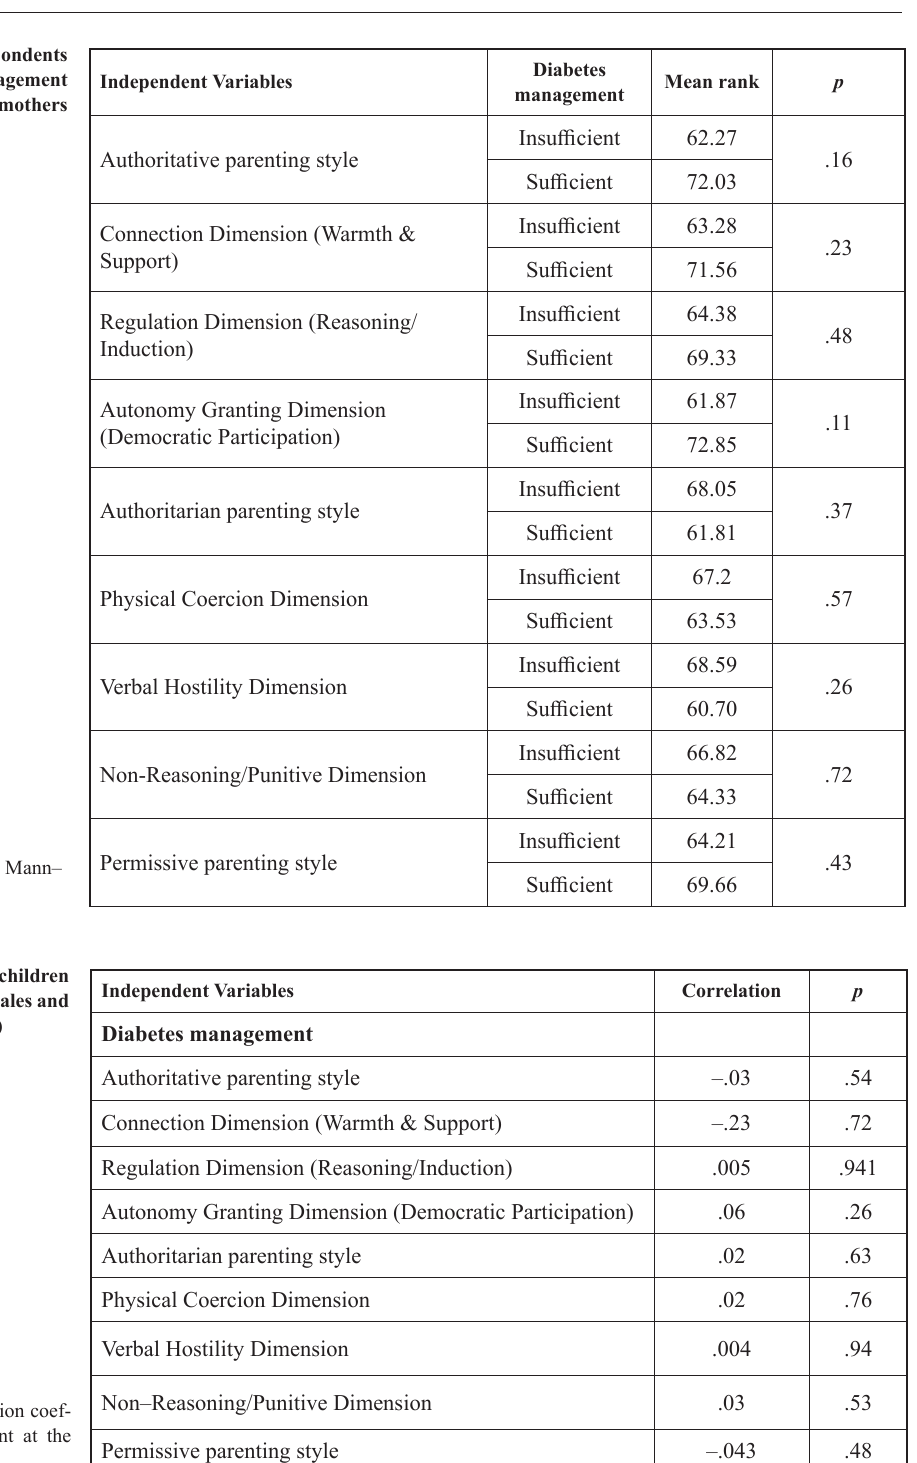
Table 4. Responses of the respondents about children T1DM management and PS scales and subscales of mothers